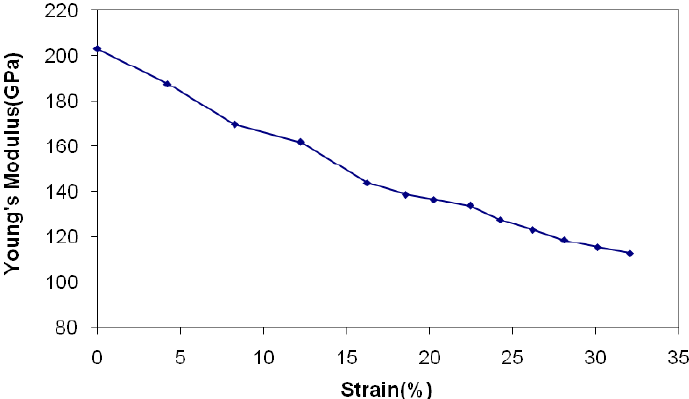
Figure 7: Change of E (Young’s modulus) for corresponding strain (%)